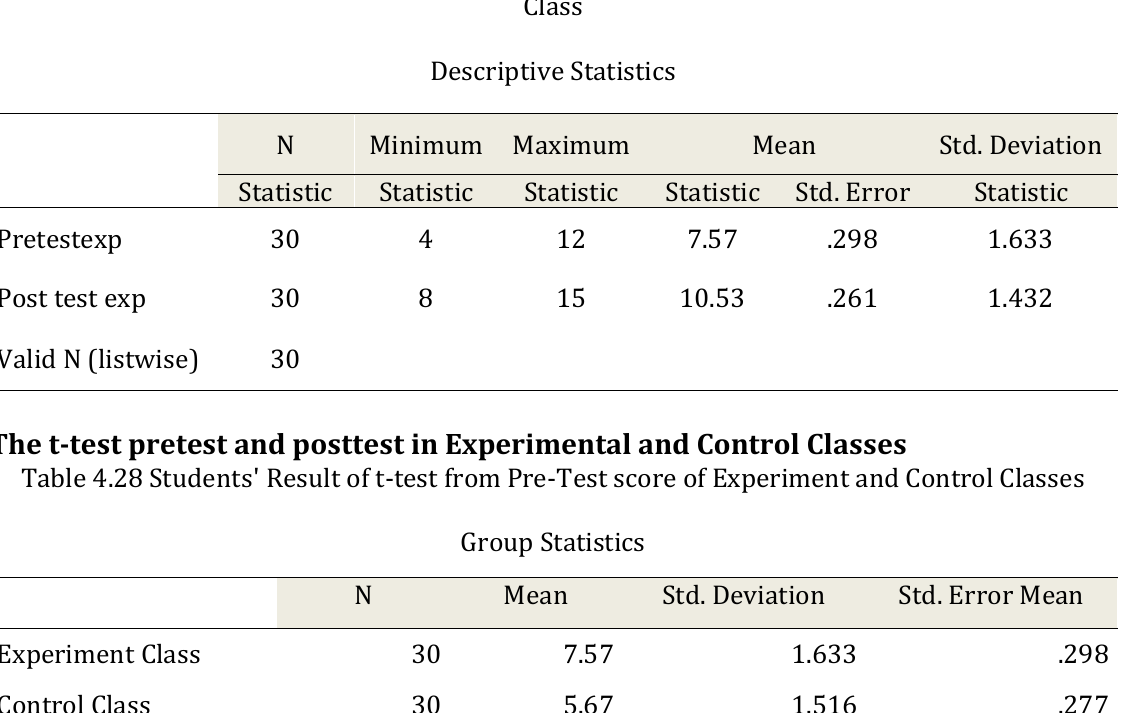
Table 4.27 Mean Score and Standard Deviation of Students' Pretest and Posttest in Experimental